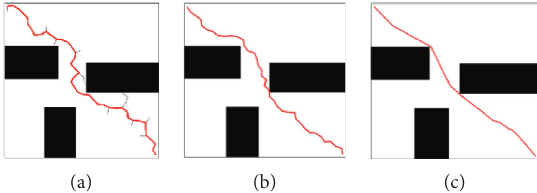
Figure 6: Map 3 running path diagram. (a) RRT. (b) ACO. (c) Ant colony optimization RRT.